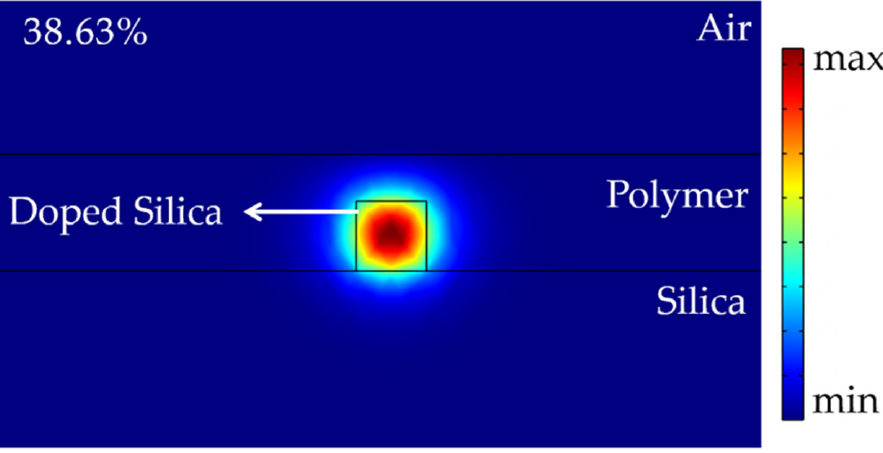
Figure 5. Optical field distribution of the non-heating arm.